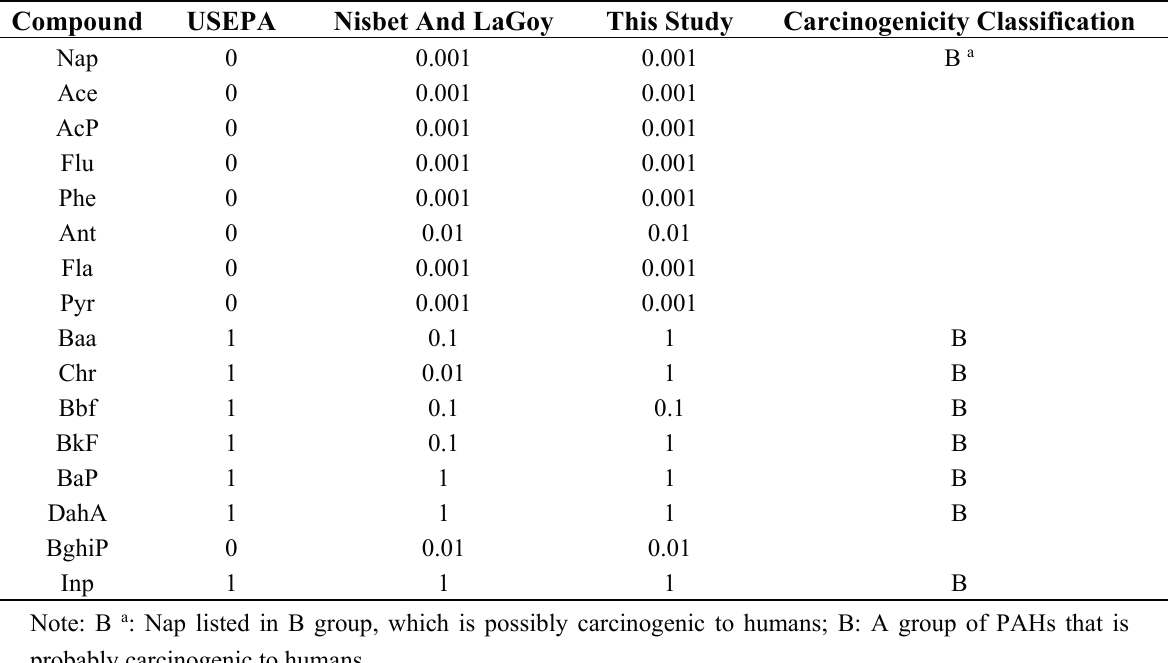
Table 2. Proposed TEFs for individual PAHs.